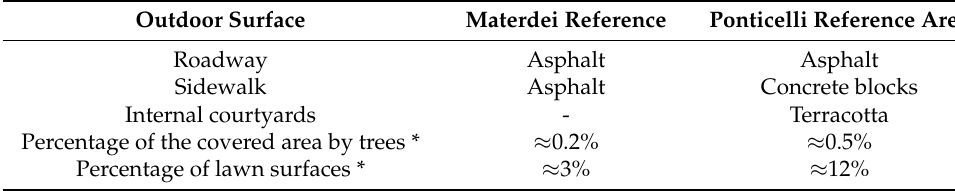
Table 2. Types of surface materials in the open spaces of the two reference